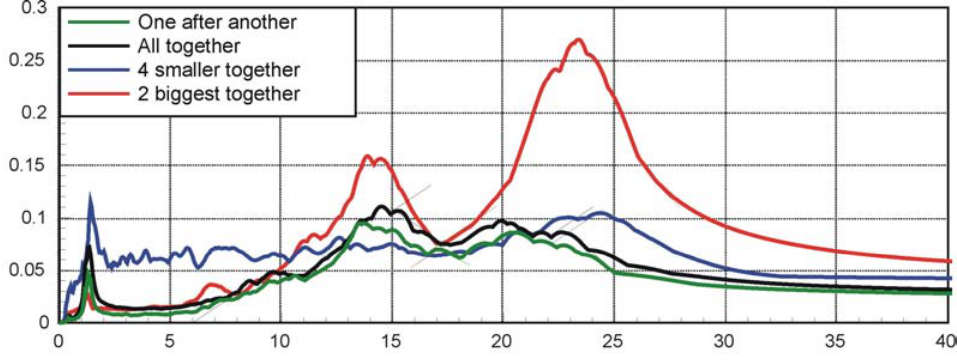
Fig. 9. Response spectra obtained for different loading systems (with 5 %